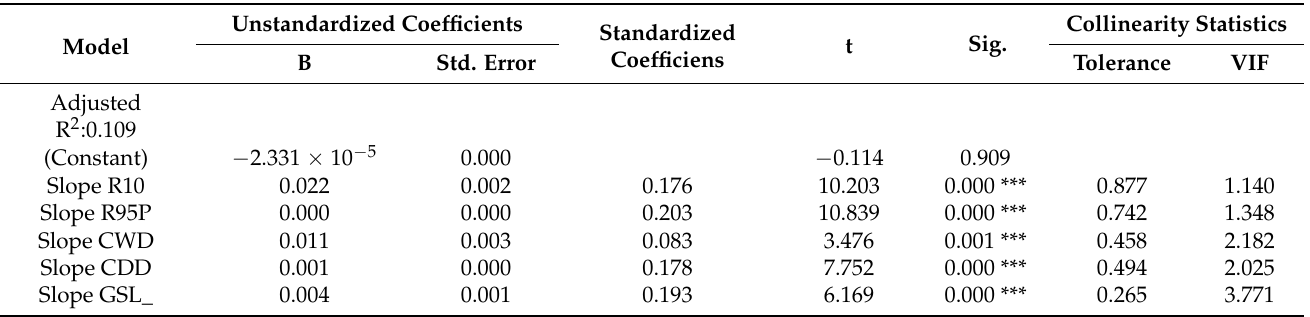
Table 2. Model of the impact of extreme climate on the normalized difference vegetation index (NDVI) of meadow